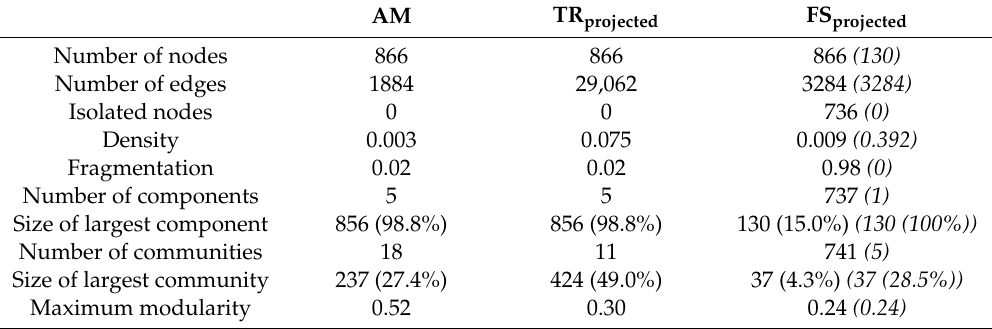
Table 2. General network parameters of the animal movements network (AM), the projected transportation network (TR projected ) and the projected feed supply network (FS projected ). For the projected feed supply network, the italic numbers in parentheses illustrate the values calculated without isolated farms.